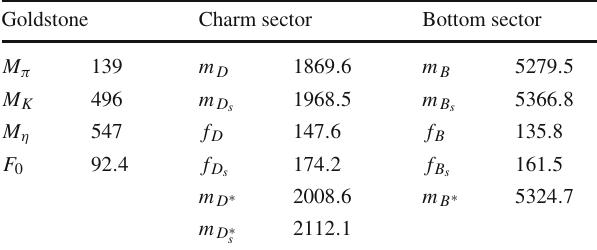
Table 2 Properties of the D ∗ amplitudes derived in Ref. [56] √